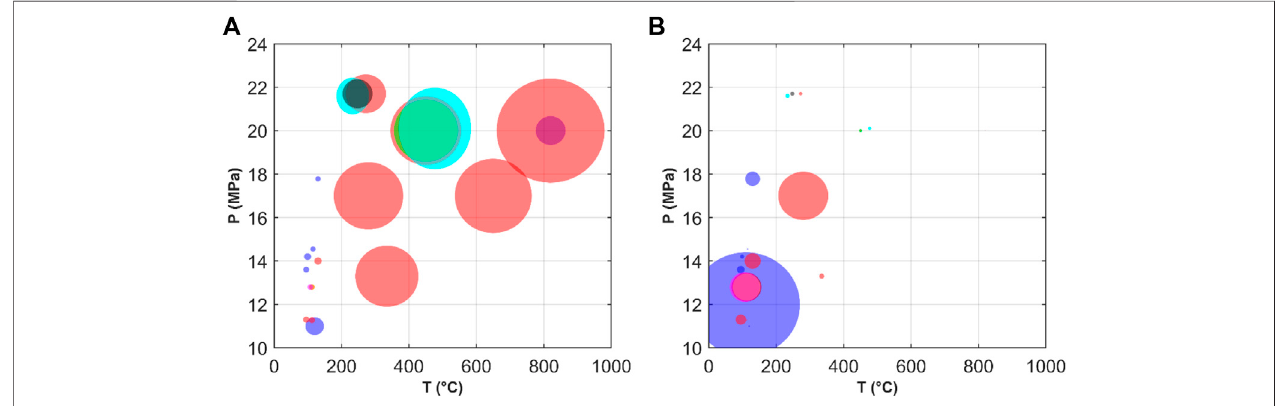
FIGURE 7 | Boundary conditions of tCO 2 cycles as a function of the maximum operation temperature and pressure: (A) Thermal ef fi ciency; (B) Net power output (legend: simple,